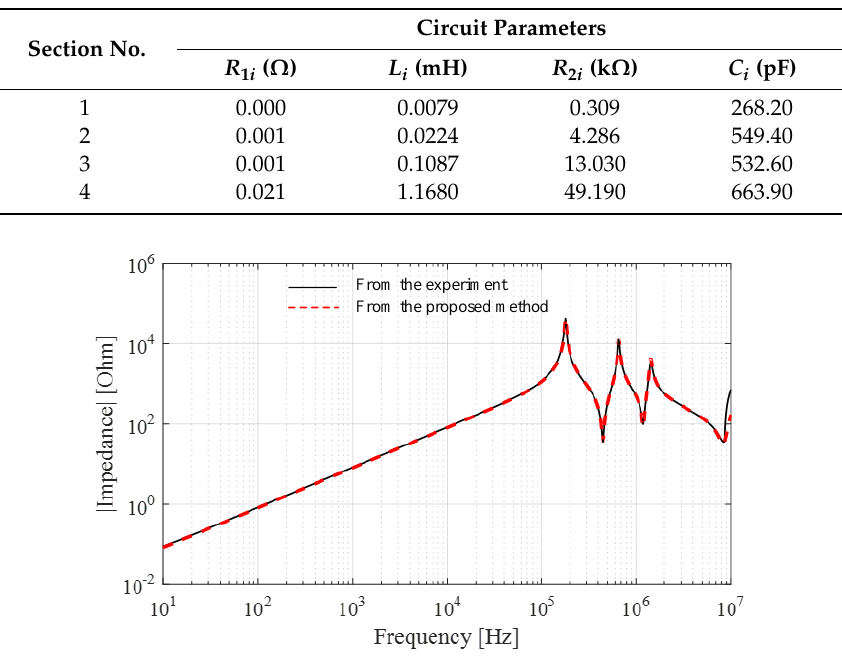
Figure 10. Magnitude of input impedances of the reactor from the measurement and the proposed method.